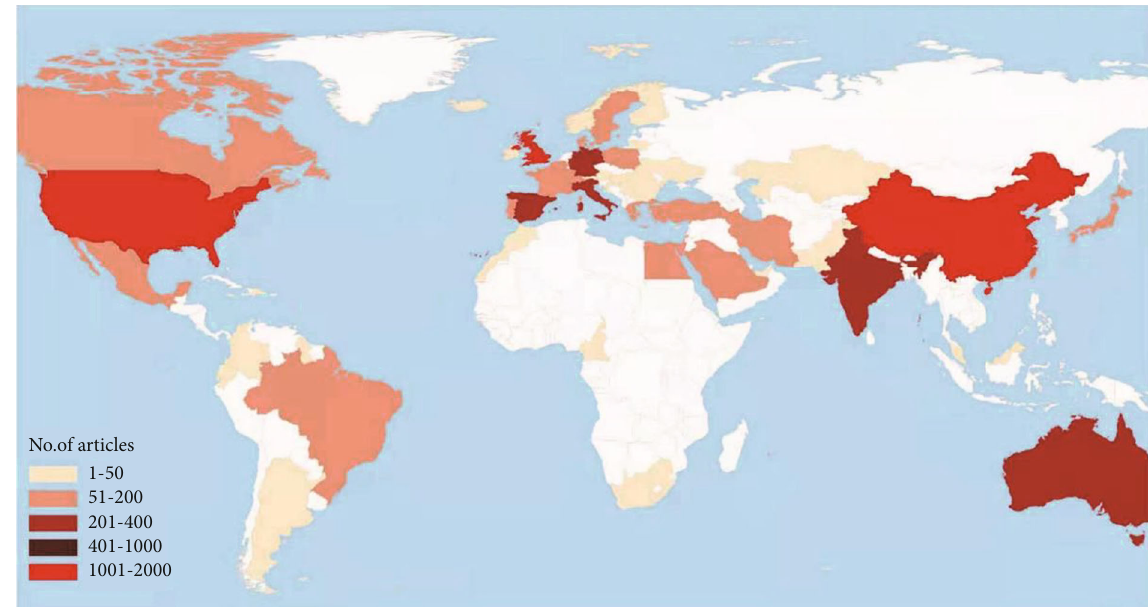
Figure 3: Geographical distribution of DFU-related research articles, 2004 –